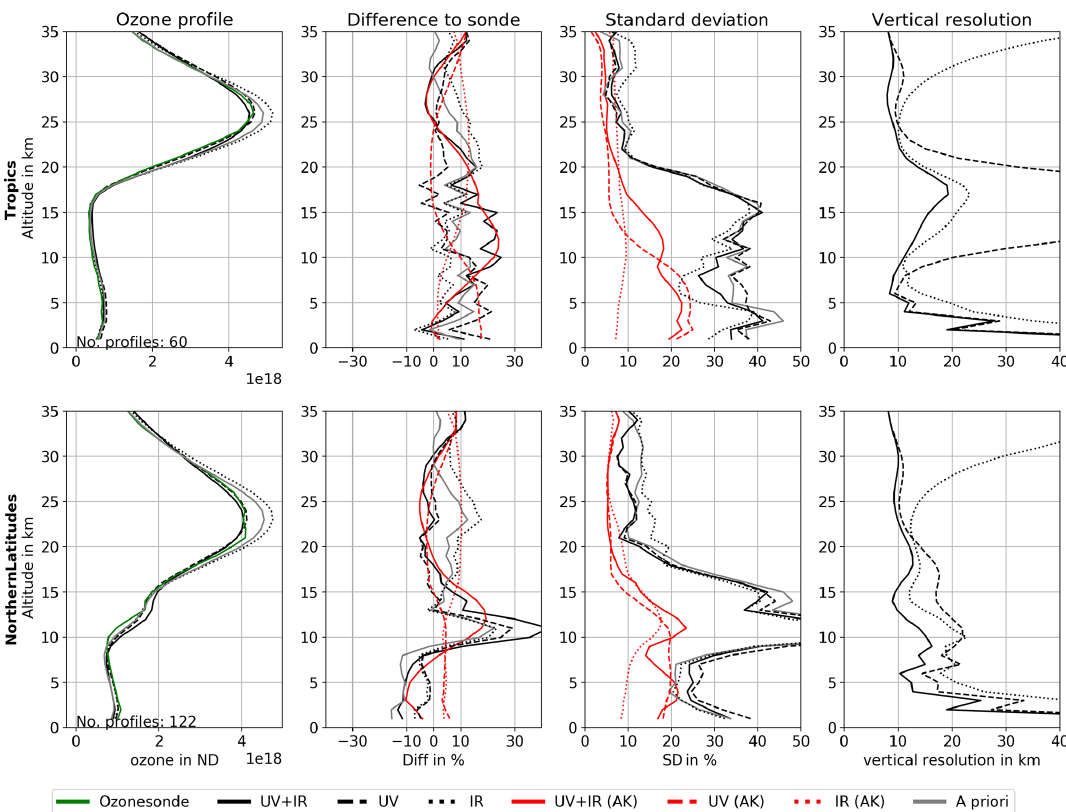
Figure 8. Ozone profile comparisons between UV + IR, UV-only, and IR-only retrievals and ozonesonde measurements for northern and tropical